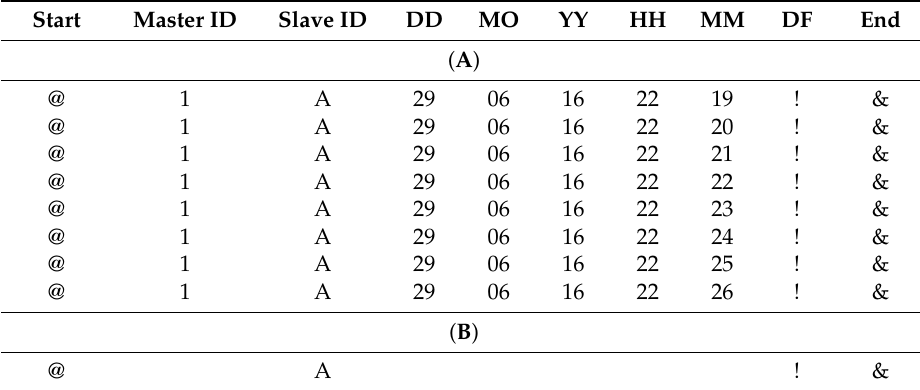
Table 4. Monitoring data frame. ( A ) Supervisor. Found people; ( B ) Supervisor. Missing people.